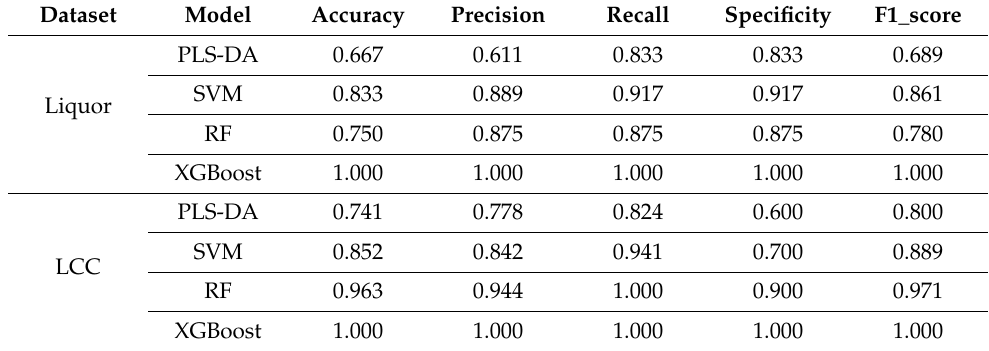
Table 4. Comparison of classification performance of different classification models on the test